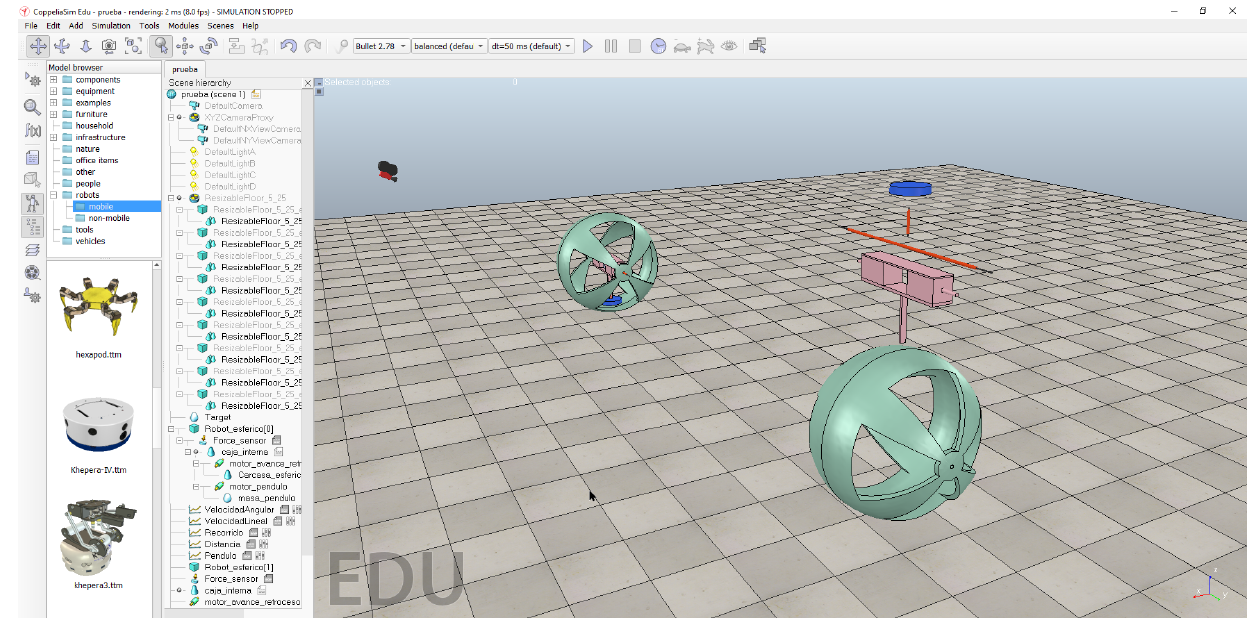
Figure 6. Assembling the robot in CoppeliaSim.